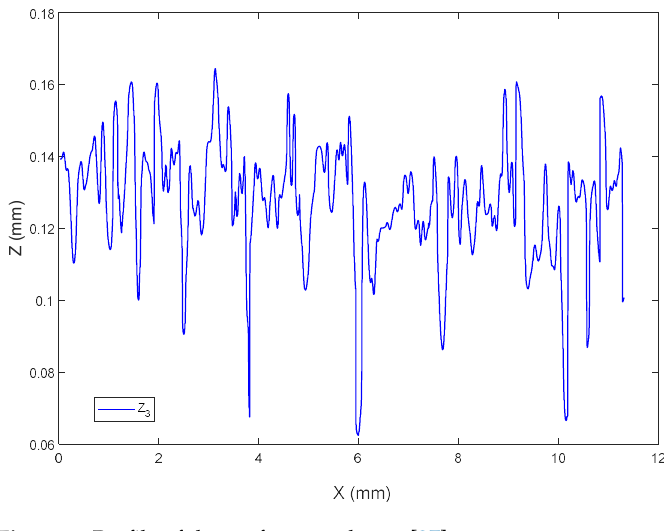
Figure 1. Profile of the surface roughness [27]. Table 1. Chemical composition (%). Reprinted with permission from ref. [18]. Copyright 2021 Springer Nature. Material